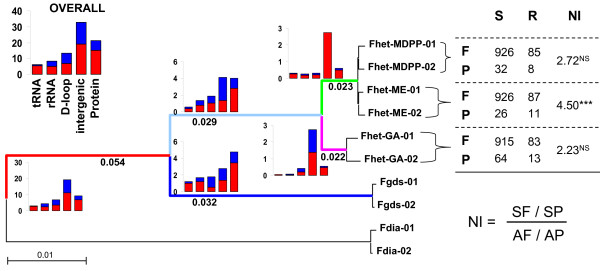
Overall and branch-specific relative transition (red) and transversion (blue) mutation rates (substitutions per 100 bases) for different genomic regions, and branch-specific dN/dS ratios (number below branch). Table includes number of pairwise (with F. grandis) synonymous (S) or amino-acid replacing (R) and fixed (F) or polymorphic (P) mutations, including neutrality index (NI) from McDonald Kreitman (MK) test performed in dnaSP. Significance of MK is tested is indicated as follows; * 0.01 < P < 0.05; ** 0.001 < P < 0.01; *** P < 0.001 for Fisher's exact test with Bonferroni correction for multiple tests. Colored lines indicate lineages referred to in Figure 5.